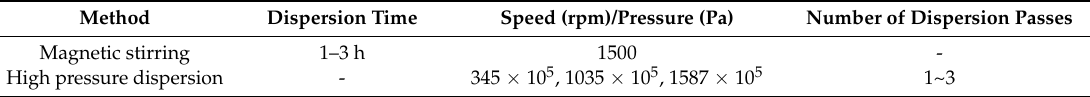
Table 4. Methods used to disperse CNCs and corresponding parameters.